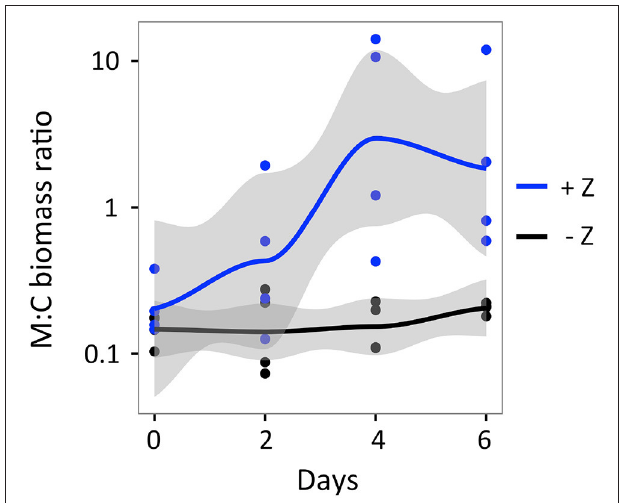
FIGURE 6 | Change in the biomass ratio of Microcystis to Cryptomonas during the 6-day facilitation experiment compared between treatments with copepods ( + Z) and no-grazer controls (–Z). Lines indicate the mean biomass ratio and the shaded area indicates the confidence interval (level = 95%).